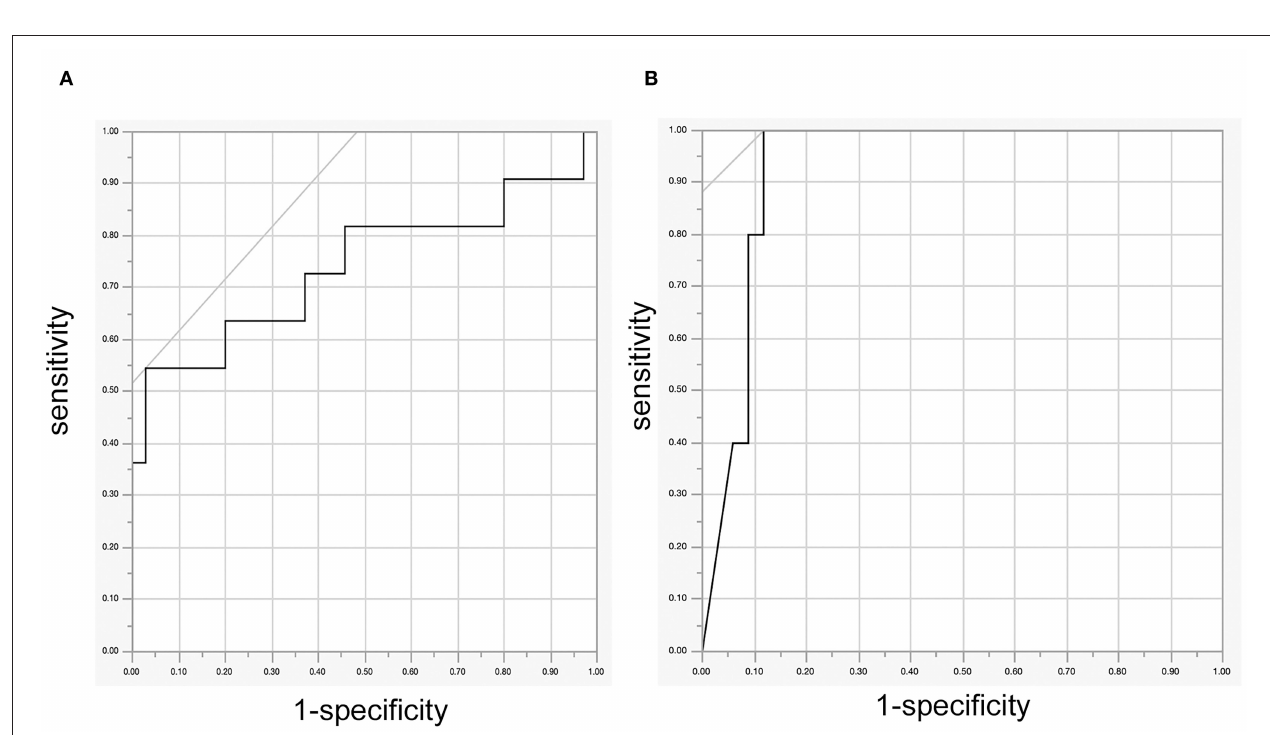
FIGURE 1 | (A) ROC curve between the Ratio motor-evoked potential (MEP) and the deterioration of the motor function of 46 extremities 2 weeks after surgery, (B) ROC curve between Ratio MEP and the deterioration of the motor function of 46 extremities at the final follow-up. ROC, receiver operating